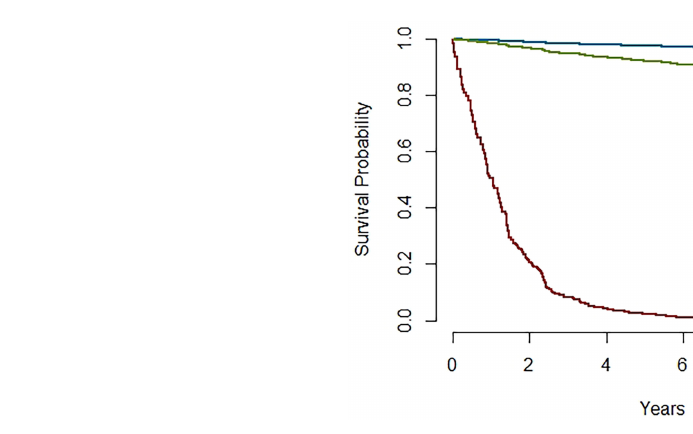
FIGURE 6 Survival probabilities for Higher (red) and Lower (blue) risk pro fi les and reference category (green).